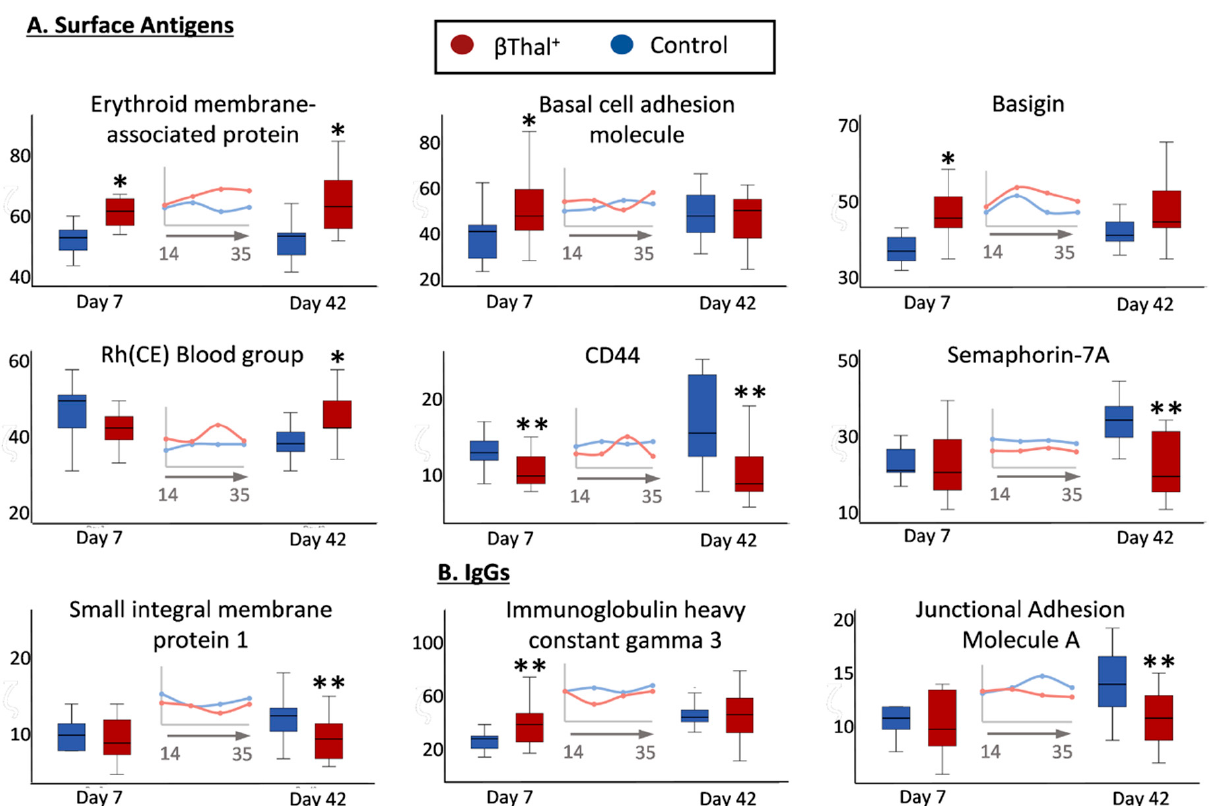
Figure 3. Proteomics analysis of stored RBC membrane: surface antigens and immunoglobulins. Levels of integral protein carriers of surface antigens ( A ) and of immunoglobulins ( B ) in β Thal + and control RBCs throughout storage. Inserts: pooled analysis of membrane samples at weekly intervals. (*) p < 0.05 β Thal + vs. controls; (**) p < 0.05 and fold > 1.25 β Thal + vs. controls.